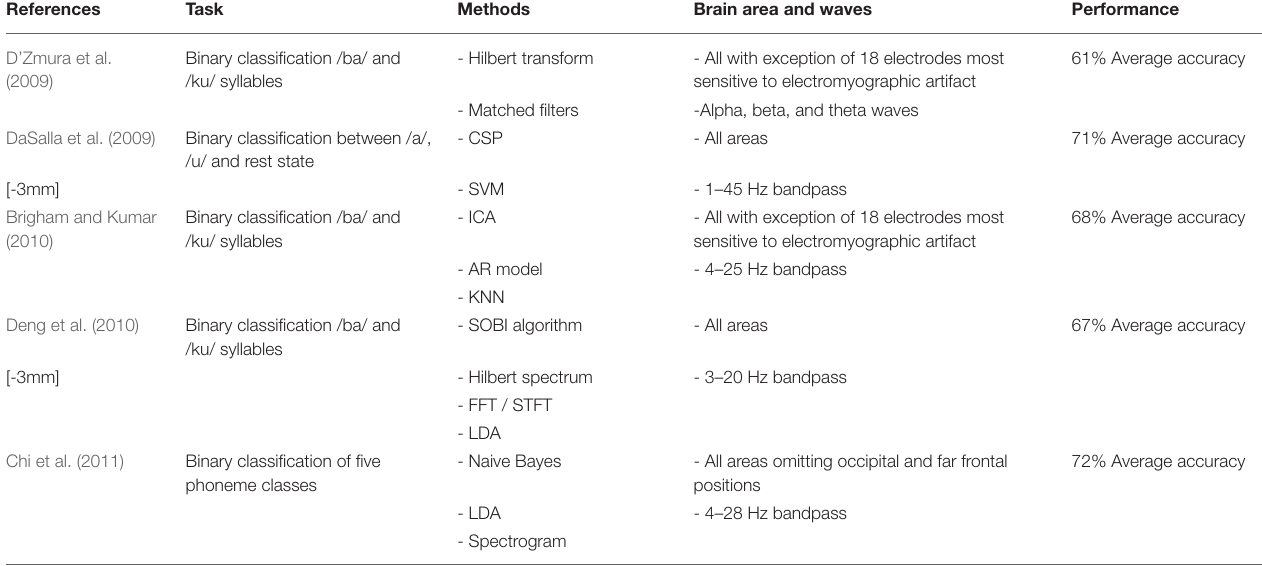
TABLE 1 | Imagined speech classification methods summary.